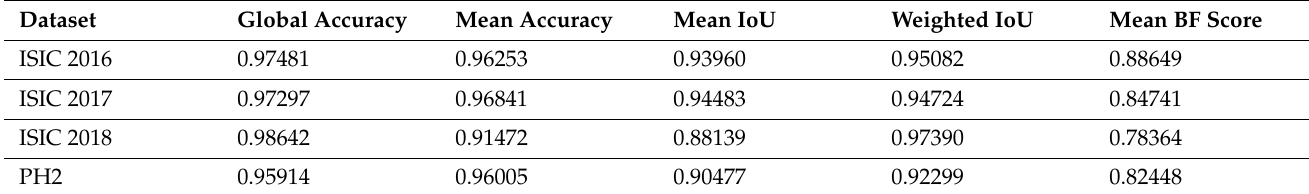
Table 6. Skin lesion segmentation performance on ISIC-2016, 2017, 2018, and PH2 datasets. Dataset